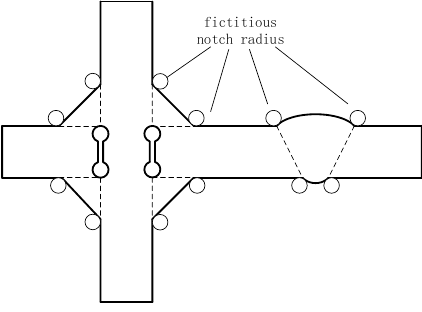
Figure 1. Fictitious notch rounding [20].